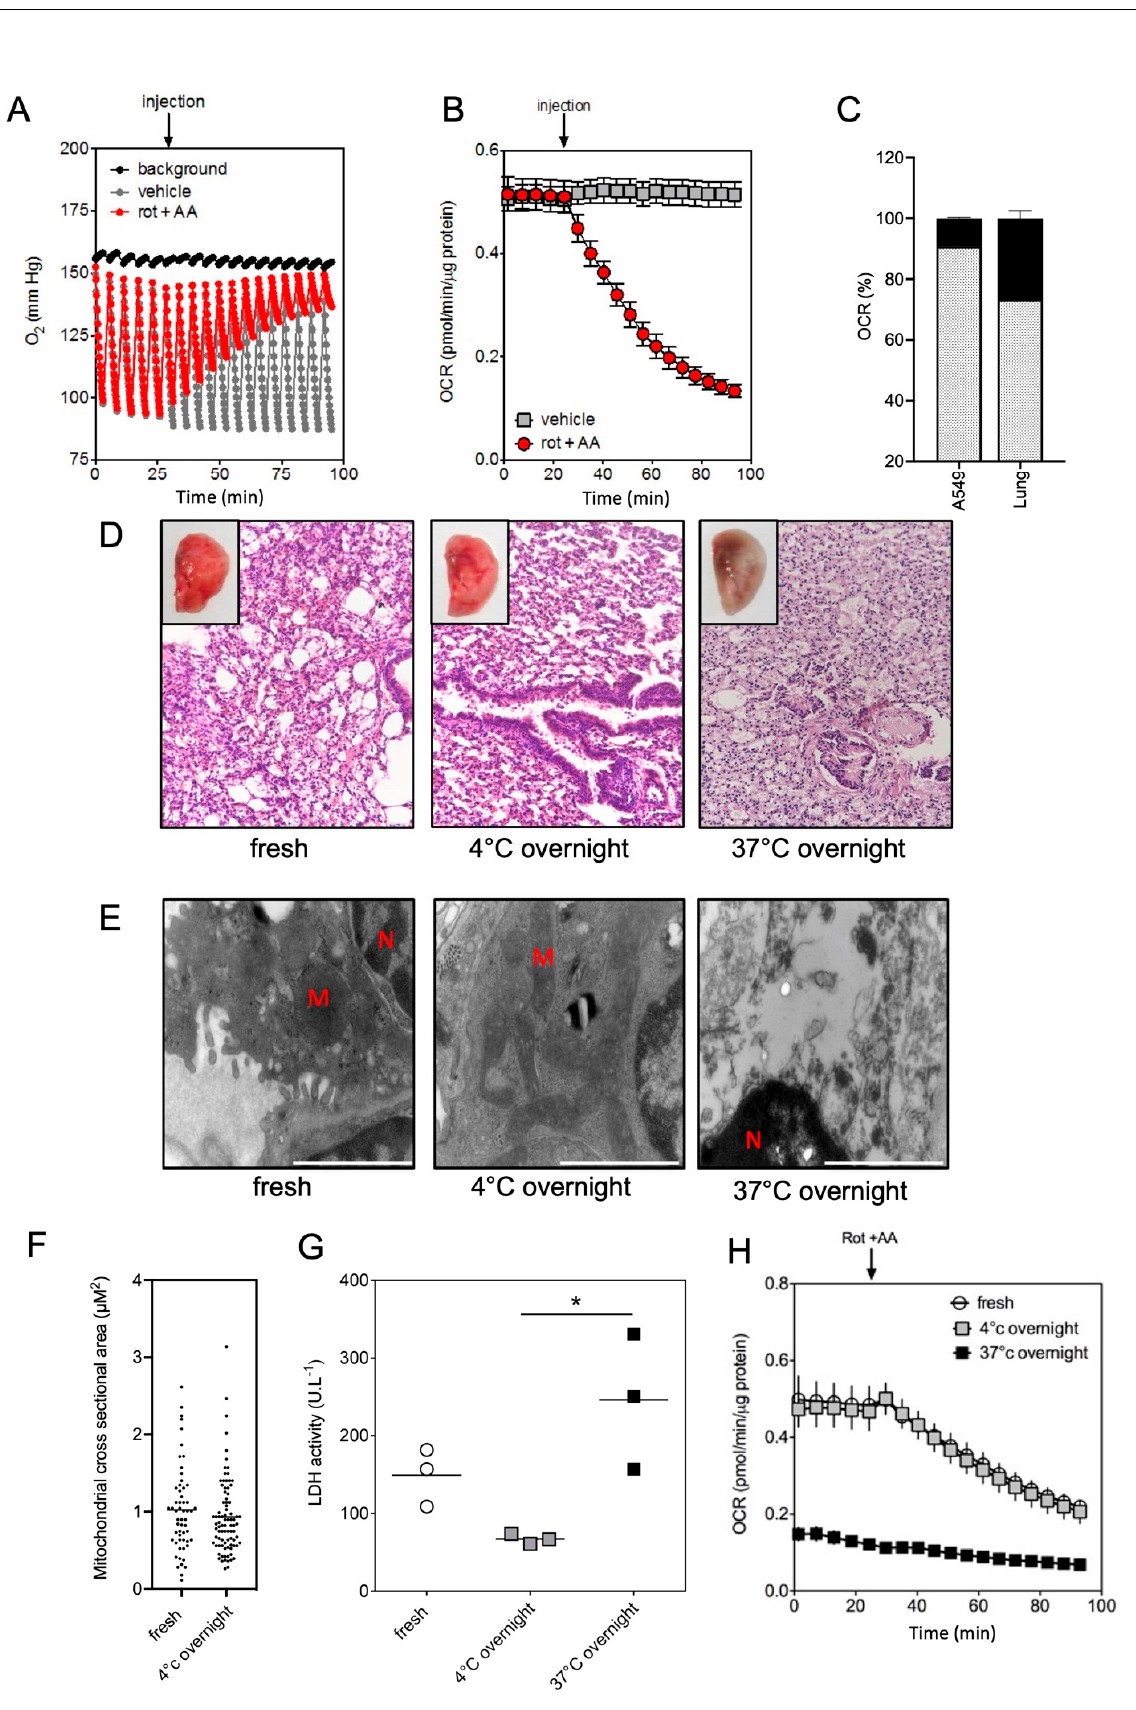
Figure 3. Oxygen (O 2 ) consumption measurements and the effect of conservation conditions in lung samples. O 2 concentration (mmHg) ( A ), oxygen consumption rate (OCR, pmol/min/µg protein) ( B )